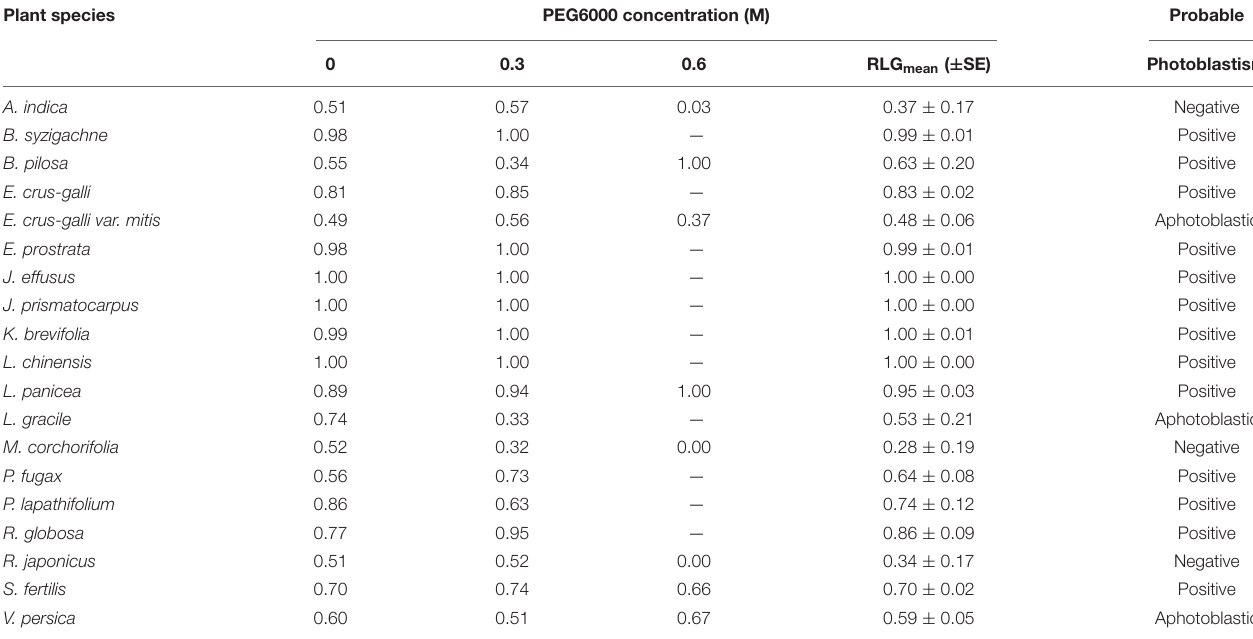
TABLE 4 | Relative light germination (RLG) and probable photoblastism. Plant